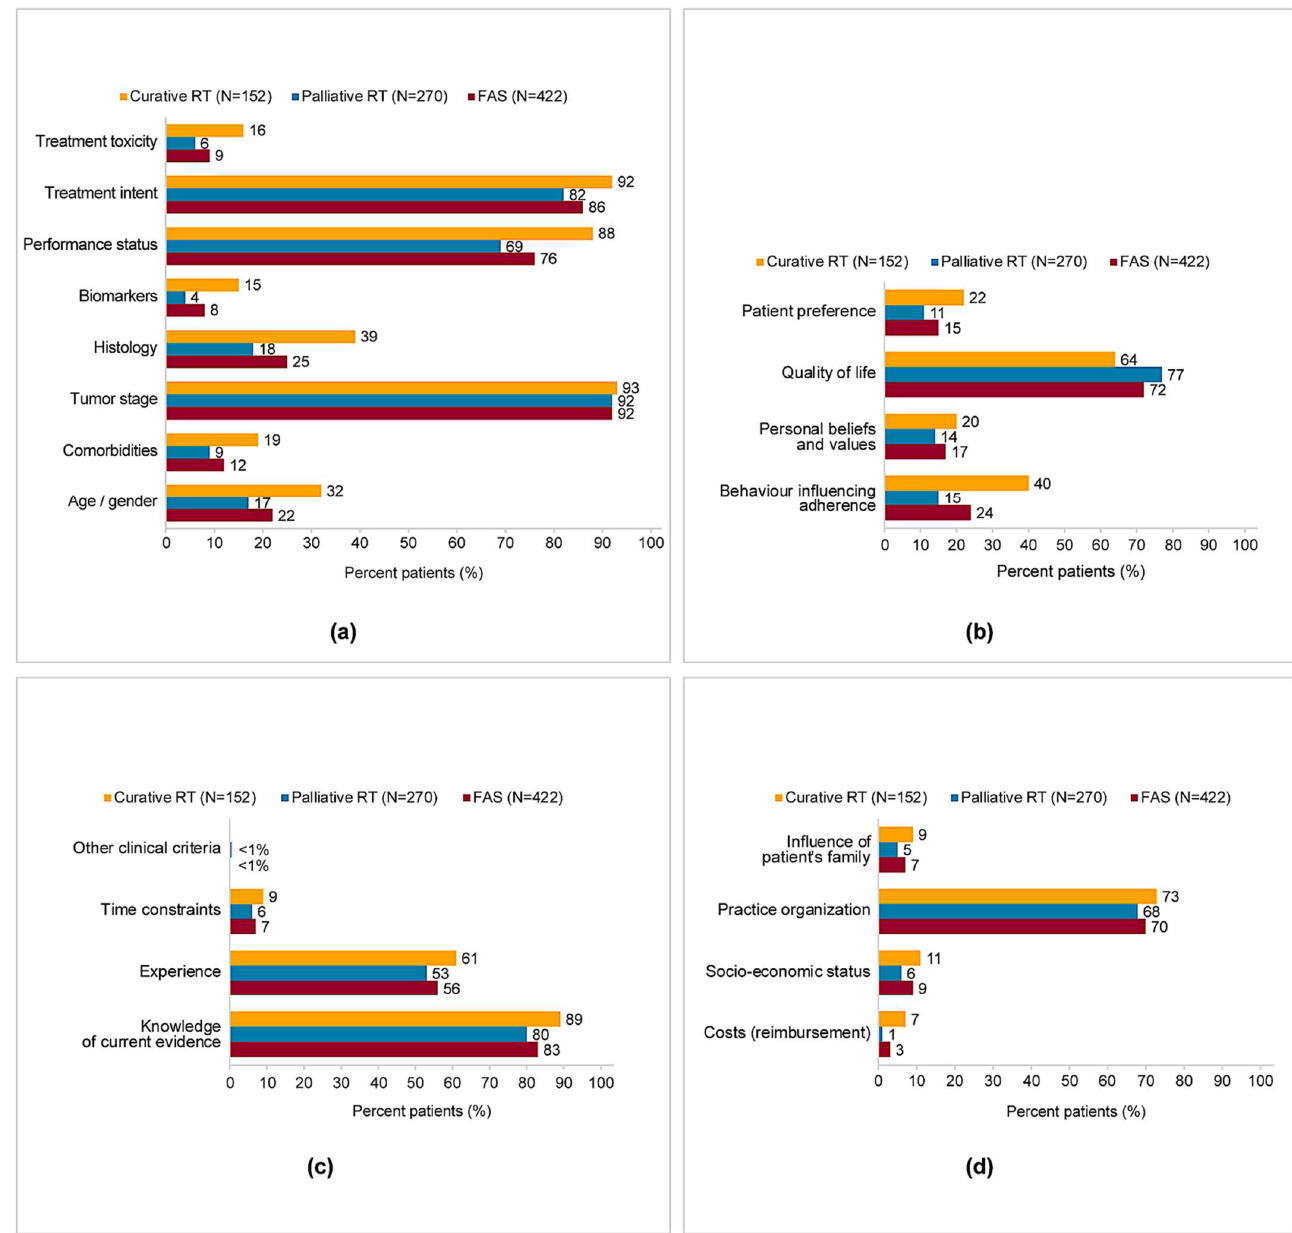
Figure 1. The drivers of medical decision to select the specific RT regimen: ( a ) disease-related criteria; ( b ) patient-related criteria; ( c ) physician-related criteria; ( d ) context-related criteria. Note: multiple responses per patient.